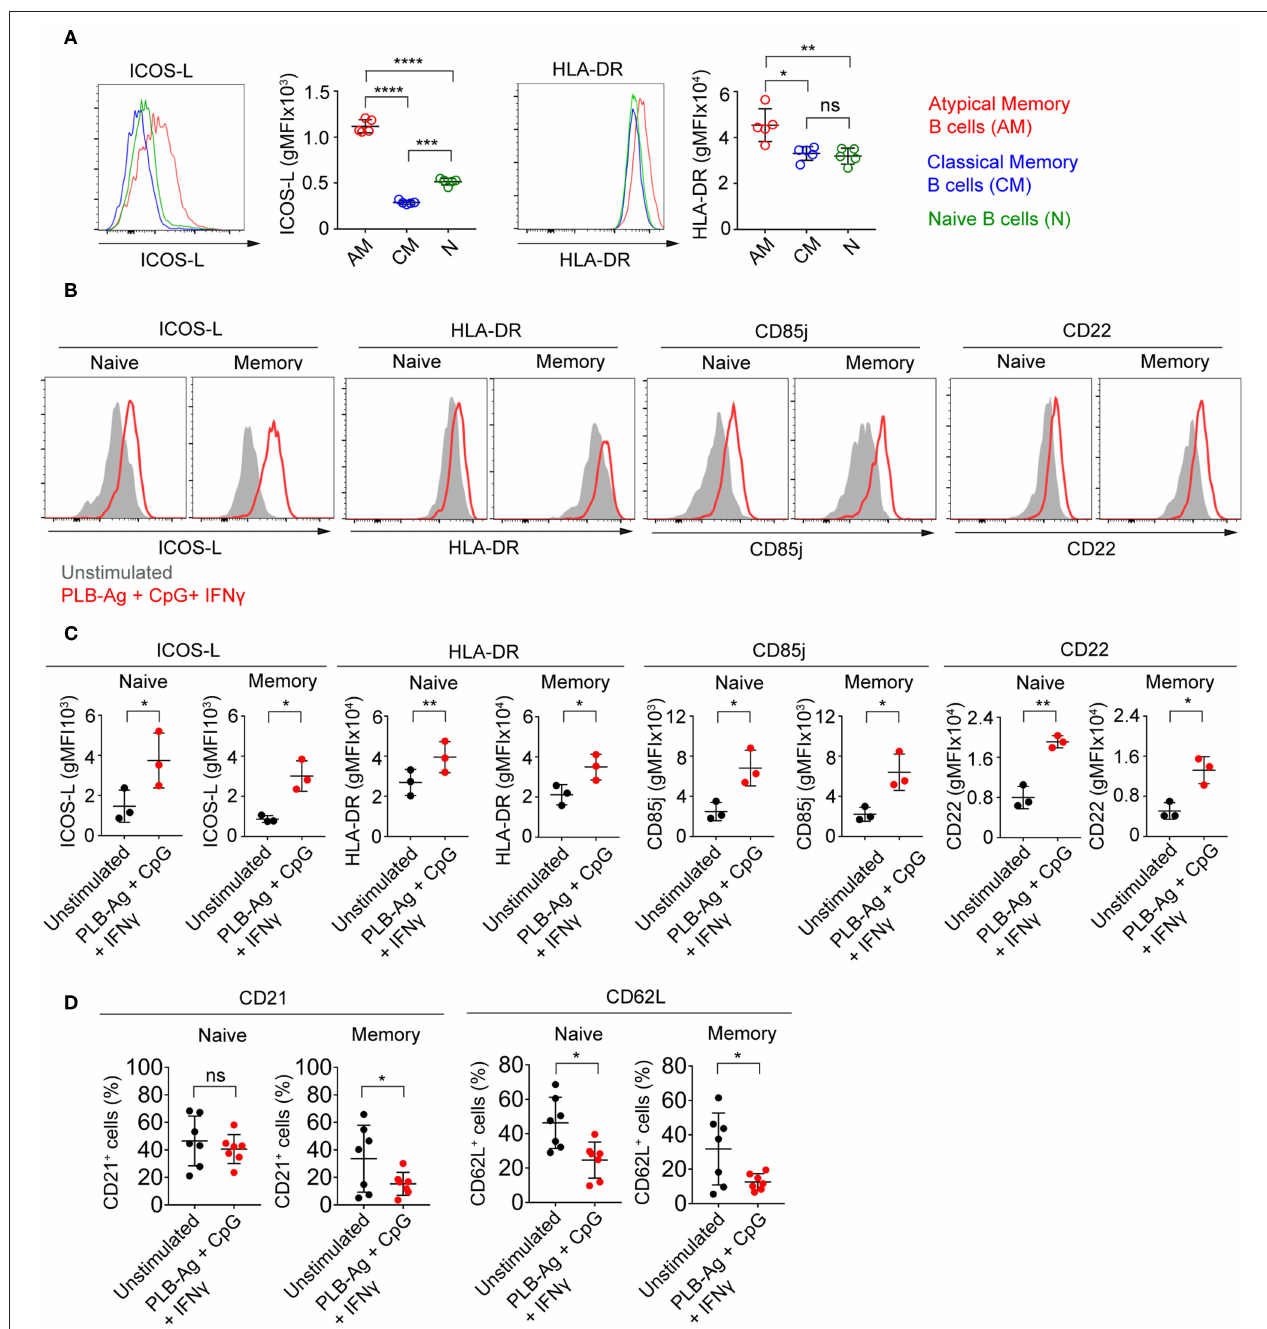
FIGURE 5 | Tonsil naïve and memory B cells stimulated in vitro upregulate ICOS-L, HLA-DR, CD85j, and CD22 and downregulate CD21 and CD62L. (A) Representative flow cytometry plots of the expression of ICOS-L and HLA-DR by atypical MBCs (CD19 + CD21 − CD27 − ), classical MBCs (CD19 + CD21 + CD27 + ), and naïve B cells (CD19 + CD21 + CD27 − ) in PBMCs isolated from Malian adults with lifelong exposure to malaria. Comparison of expression (gMFI) of ICOS-L and HLA-DR by atypical MBCs, classical MBCs, and naïve B cells ( n = 5). Data were analyzed using one-way analysis of variance (ANOVA) with Tukey’s adjustment. * P < 0.05; ** P < 0.01; *** P < 0.001; **** P < 0.0001; ns, not significant. (B) Representative histograms of tonsil naïve and memory B cells following culture in vitro for 40h without stimulation (gray shaded area) or stimulated (red tracing) with antigen presented on PLB in the presence of CpG and IFN- γ and analyzed by flow cytometry for the expression of ICOS-L, HLA-DR, CD85j, and CD22. (C) Comparison of the expression (gMFI) of ICOS-L, HLA-DR, CD85j, and CD22 by naïve and memory B cells as in (B) ( n = 3). Data were analyzed using paired t test. * P < 0.05; ** P < 0.01. (D) Percentage of naïve and memory B cells expressing CD21 and CD62L after in vitro culture for 40h either without or with PLB-Ag + CpG + IFN- γ stimulation ( n = 7). Data was analyzed using paired t -test. * P < 0.05; ns, not significant.